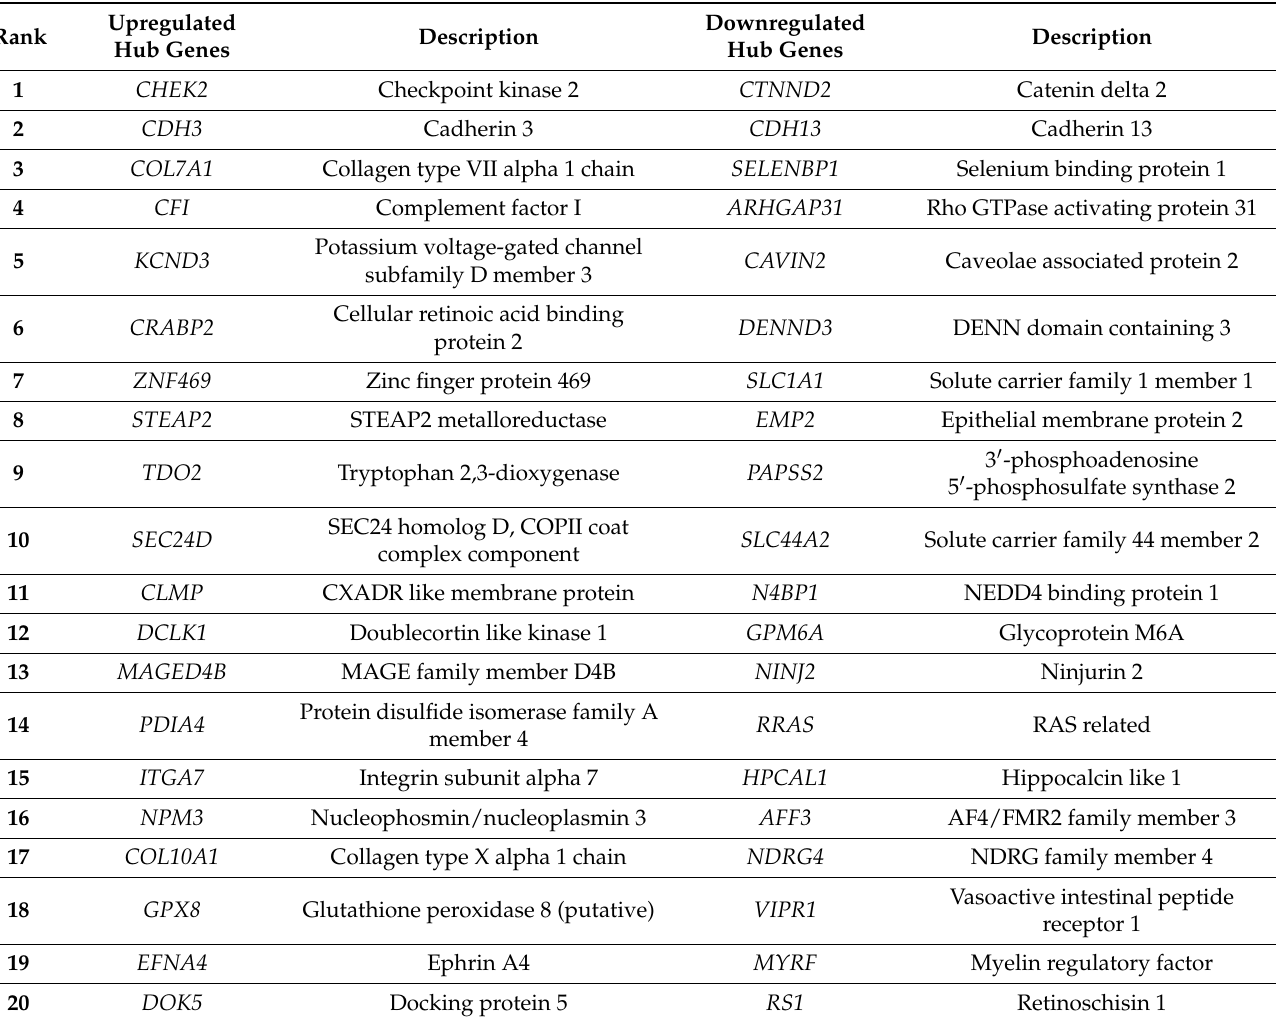
Table 4. Top 20 ranked novel hubs ranked based on their functional similarities to known GWA IPF genes. Upregulated and downregulated hubs are ranked